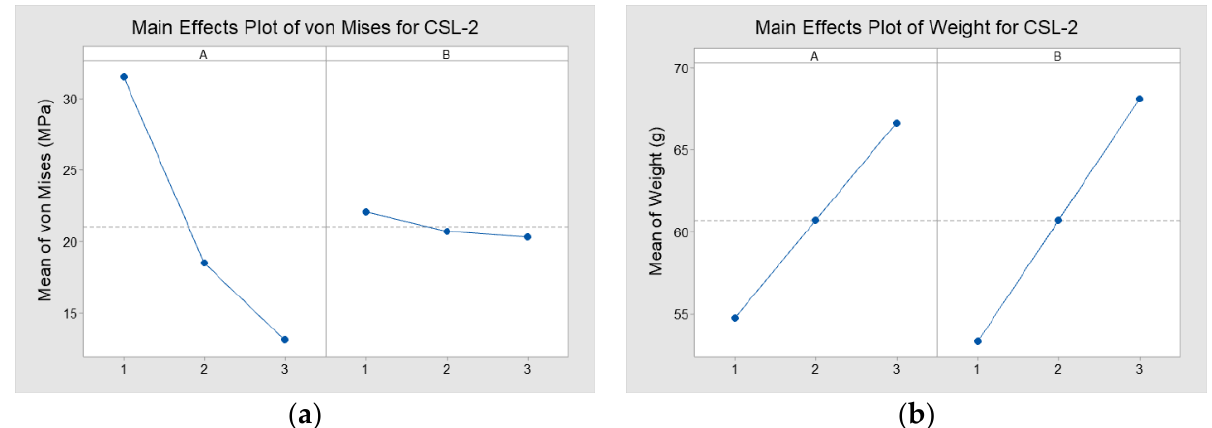
structure weight.